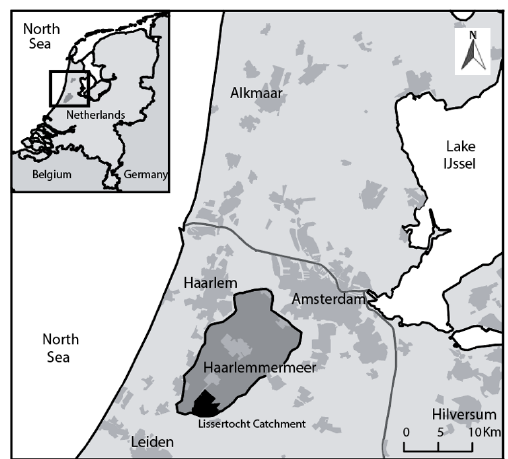
Figure 1. Location of the case study area (Lissertocht catchment) shown in Netherlands (adopted from